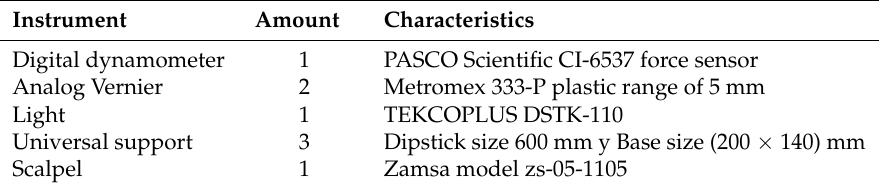
Table 3. Instruments for the measurement process.